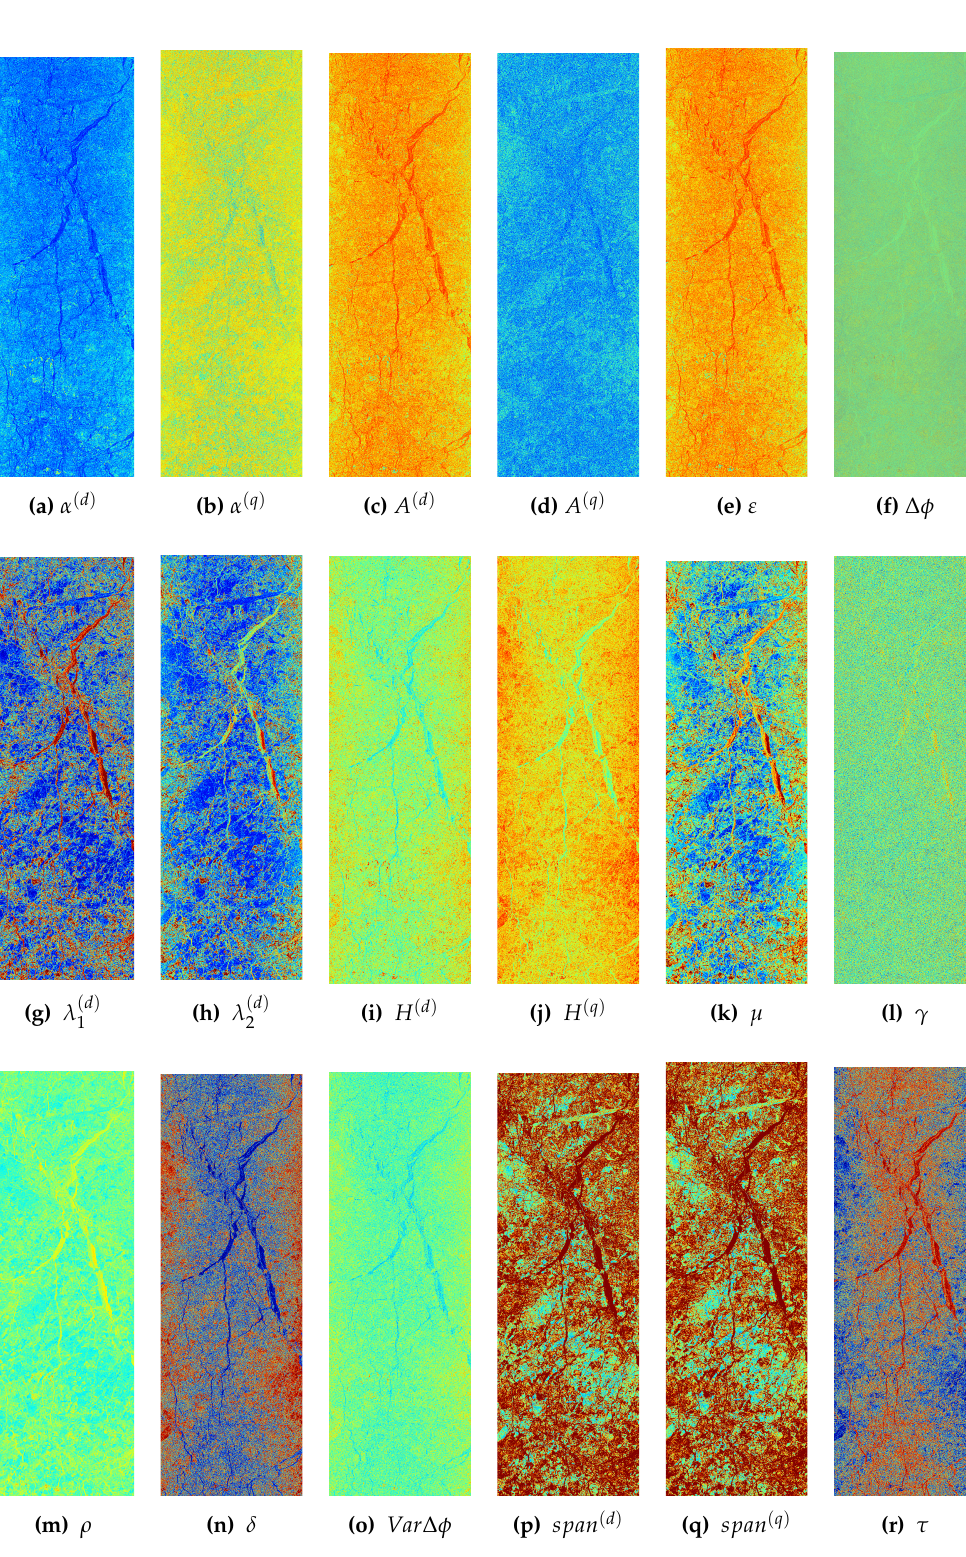
( d ) ( d ) ; ( h ) λ ; ( i ) H ( q ) ; ( j ) H ( q ) ; ( k ) µ ; ( l ) γ ;, ( m ) ρ ; ( n ) δ ; ( o ) Var ∆ φ ; ( p ) span ( d ) ; 2 1